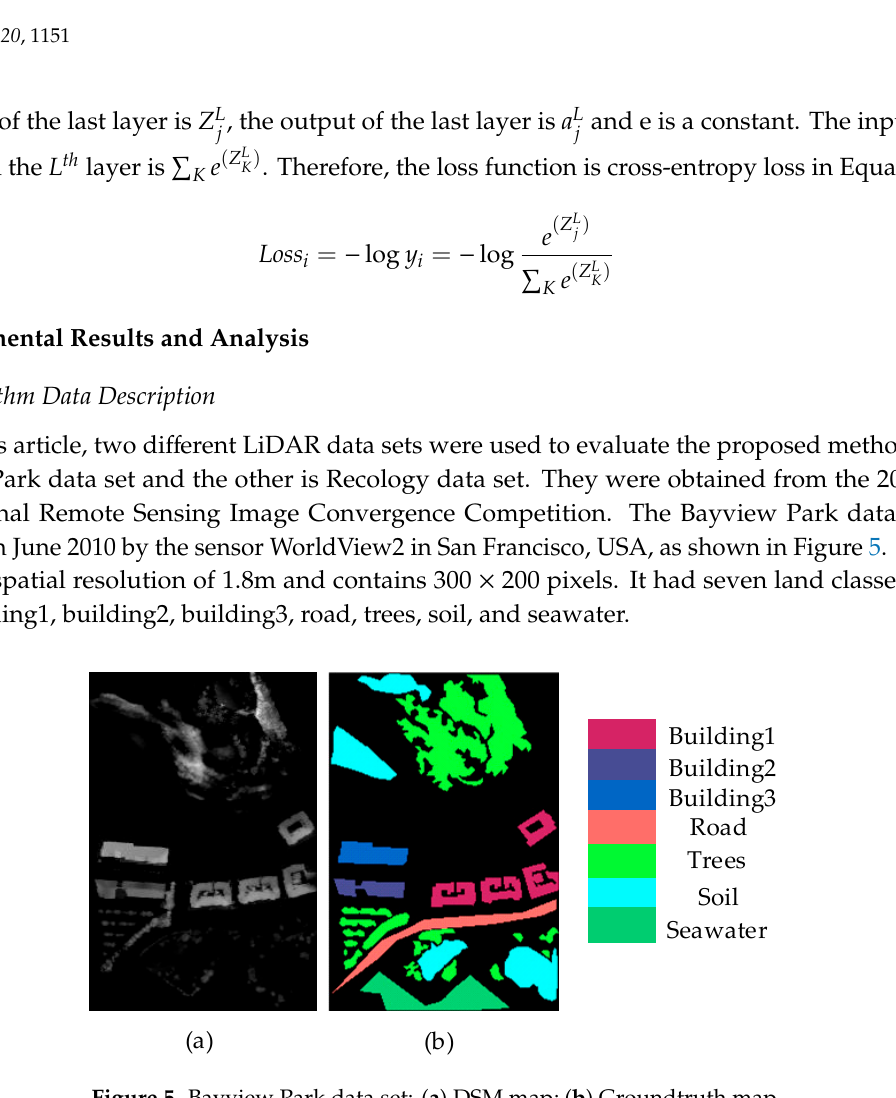
Figure 5. Bayview Park data set: ( a ) DSM map; ( b ) Groundtruth map.